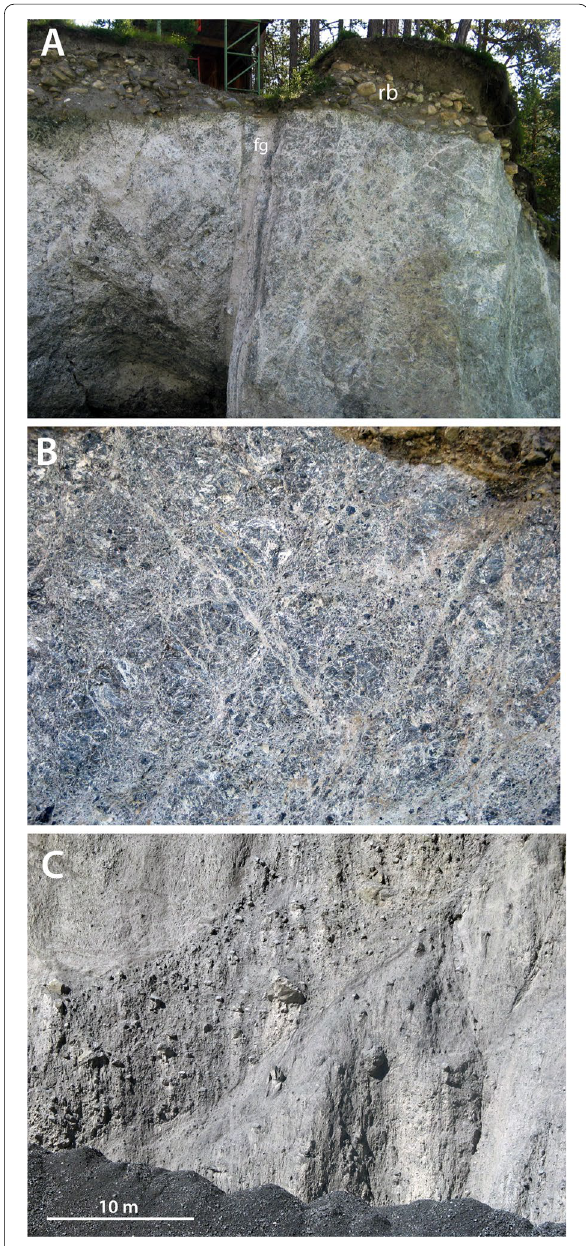
Fig. 23 Fragmentation and comminution of limestone in the rock avalanche deposit A Overview of outcrop at Isla Casti. A major fault with a thick gouge (fg) is accompanied by parallel faults and splaying faults with thinner gouge. Top of outcrop is a perched river bed (rb). B Detailed view of the outcrop at Isla Casti. Brecciation of Quinten Limestone occurred by multiple generations of veins. Vein filling is light colored and consists of comminuted limestone. C Quarry outcrop at Carnifels. A distinct band with larger angular blocks cuts across brecciated limestone. Fault gouge is developed along the contacts. Photos A.